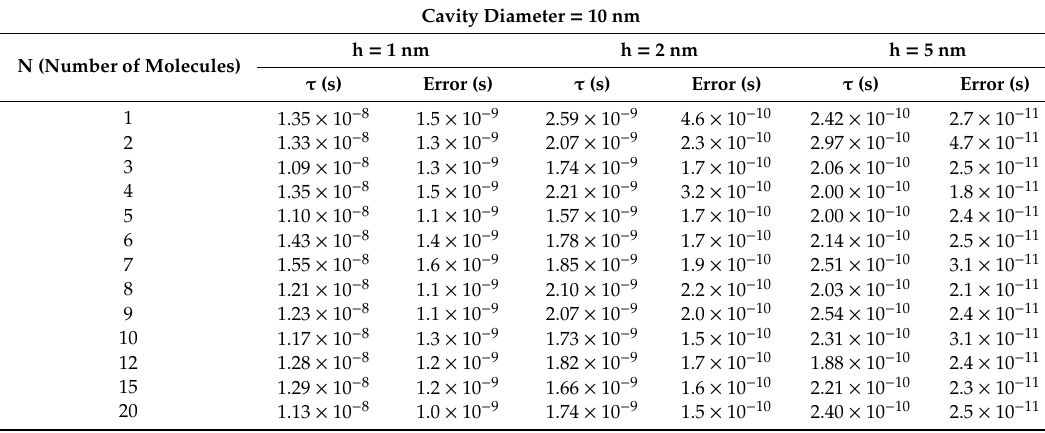
Table A4. Mean escape time ( τ ) and associated errors of di ff erent number molecules confined in a 10-nm spherical cavity for di ff erent entrance–escape hole diameters (h) calculated by the interactive random walk models for 10 2